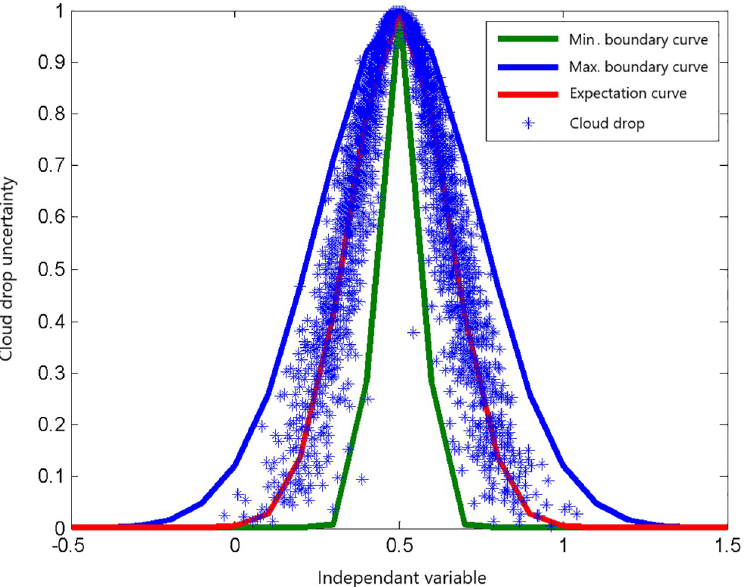
Fig 1. The schematic diagram of boundary curve and expectation curve of the model cloud